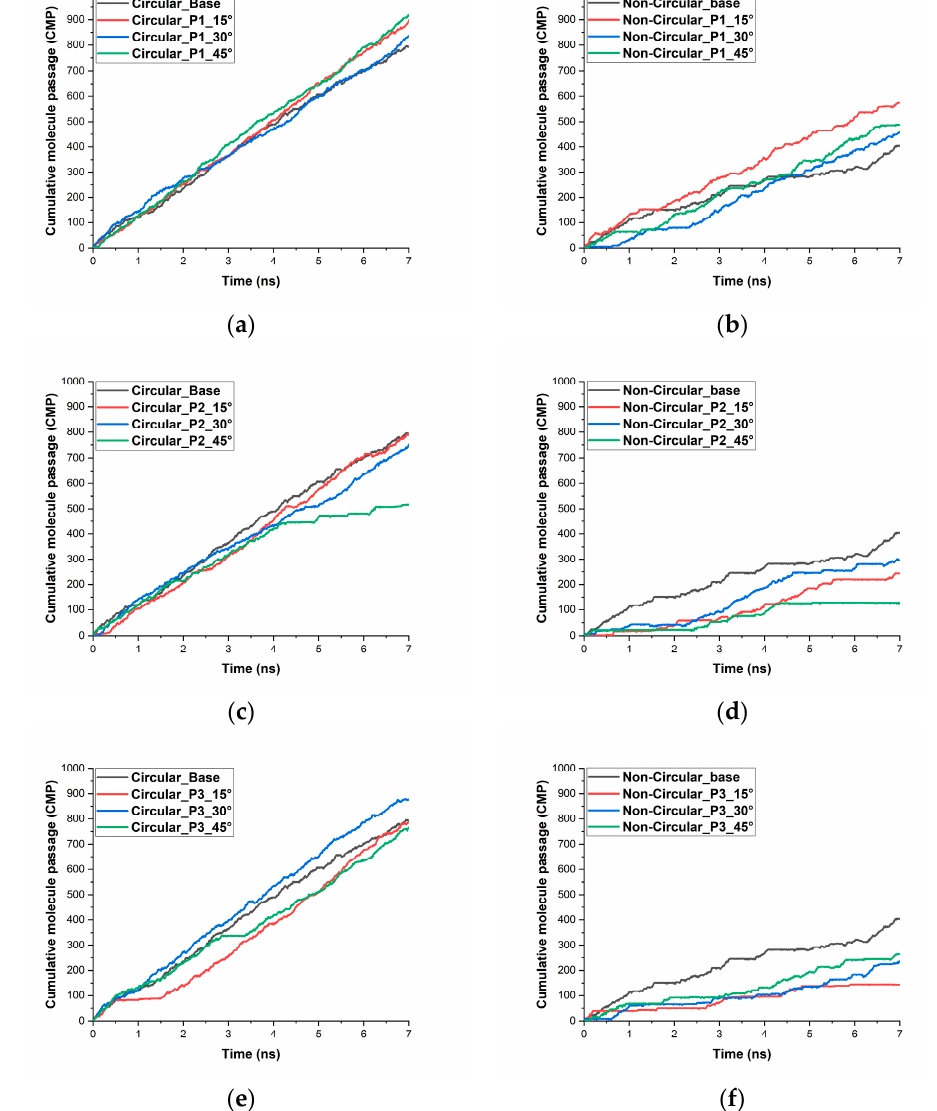
Figure 3. The cumulative molecule (water) passage through multilayered graphene nanopore ( a ) circular pore with pattern 1 ( b ) Non-circular pore with pattern 1 ( c ) circular pore with pattern 2 ( d ) Non-circular pore with pattern 2 ( e ) circular pore with pattern 3 ( f ) Non-circular pore with pattern 3.